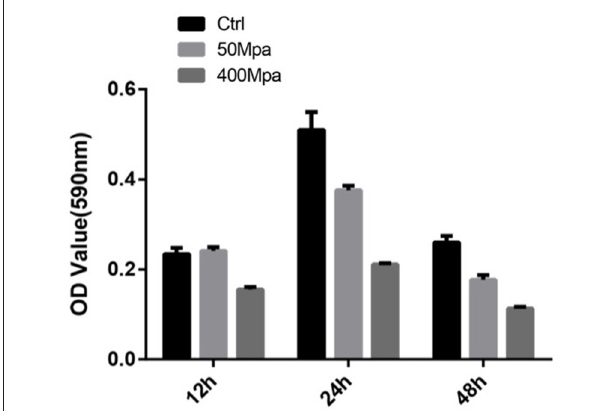
FIGURE 5 | Biofilm formation of E. sakazakii incubated at 12, 24, and 48h. Vertical error bars represent standard deviations of three replicate samples.